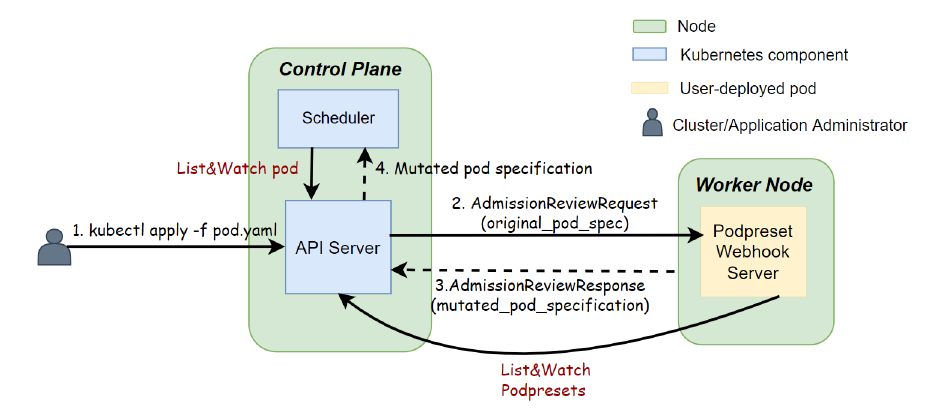
Figure 3. Redhat-COP PodPresets admission webhook